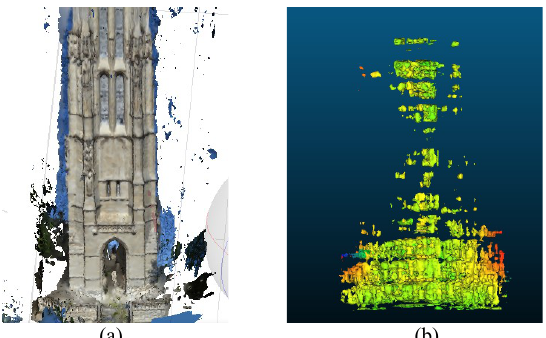
(b) Figure 7. Models obatained processing the same image dataset “tower”of the Tour Saint Jacques: (a) mesh from MVS in which only one façade was reconstructed; (b) mesh from NeRF, in which two views were reconstructed.